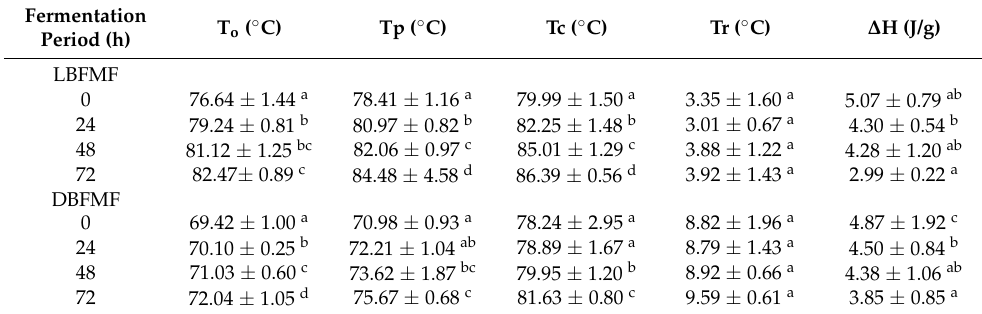
Table 3. Thermal properties of spontaneously fermented finger millet